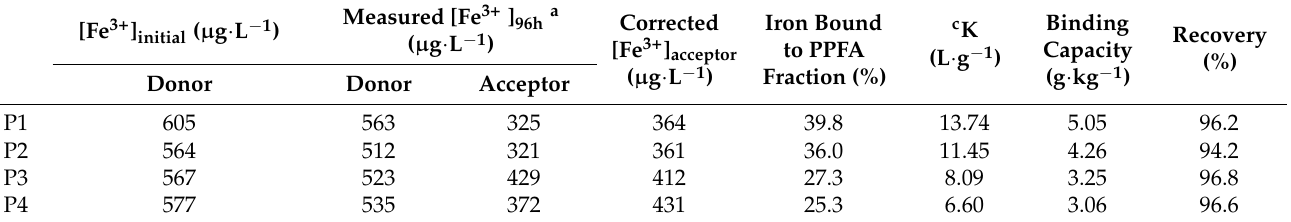
Table 4. Results of chemical speciation of iron in the solutions of PPFA with different molecular